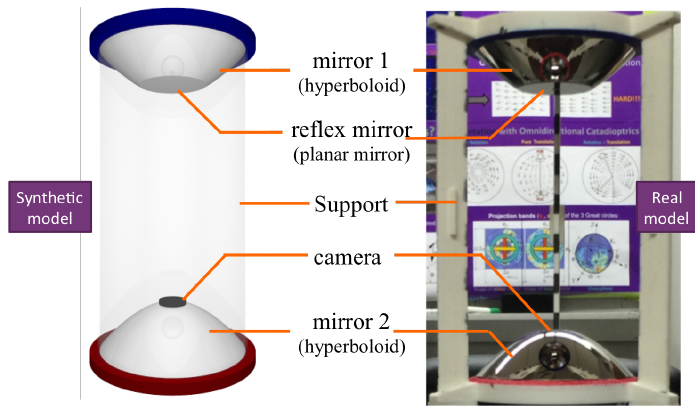
Figure 1. Synthetic and real prototypes for the catadioptric single-camera omnistereo system.